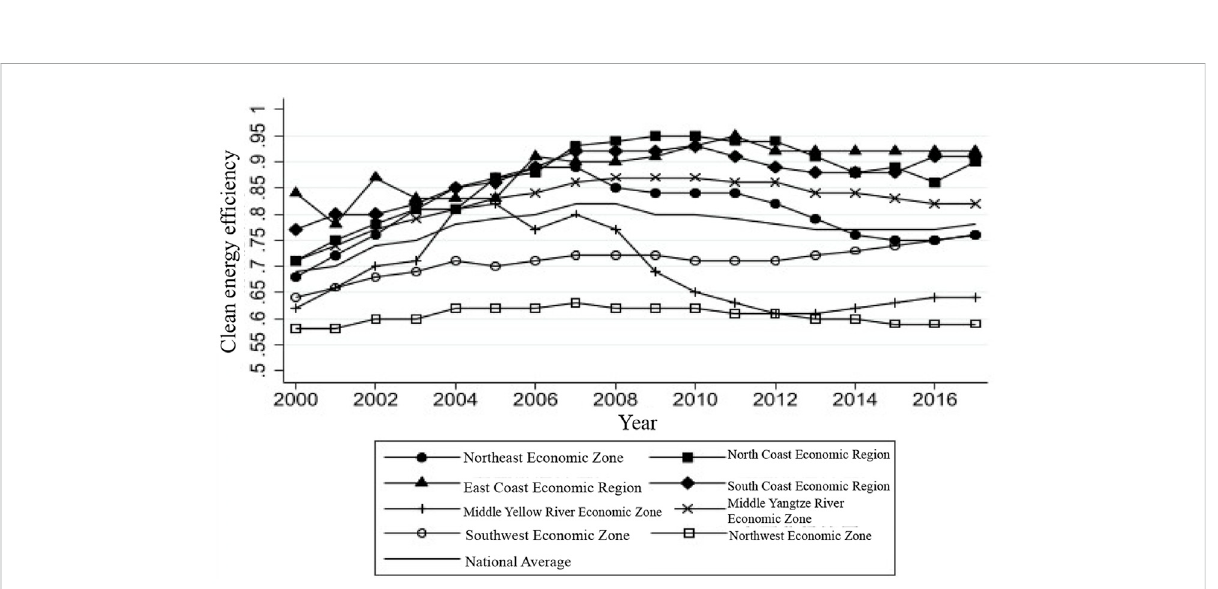
FIGURE 4 2000-2017 clean energy ef fi ciency structure of China ’ s eight economic zones (new